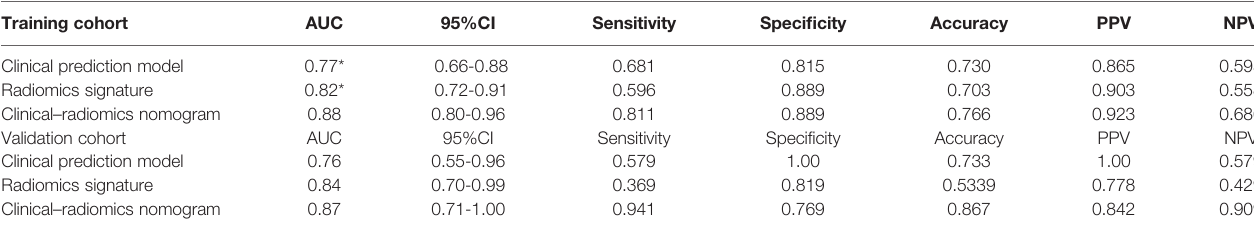
TABLE 3 | Predictive performance of three prediction models for the training and validation sets. Training